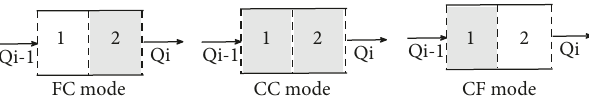
Figure 3: Traffic operation